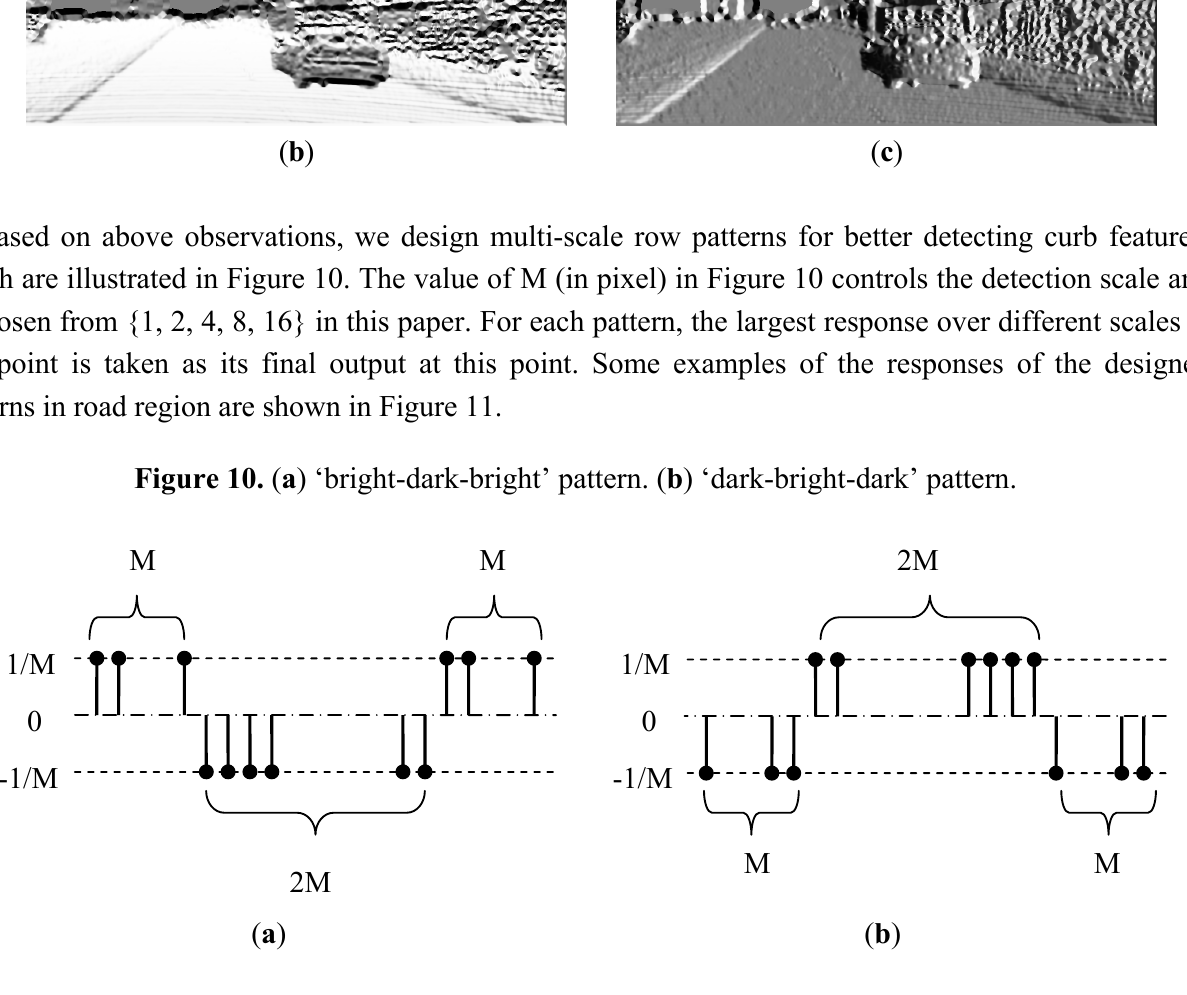
Figure 11. ( a ) ‘BDB’ pattern response on Z projection map; ( c ) ‘BDB’ pattern response on X X W